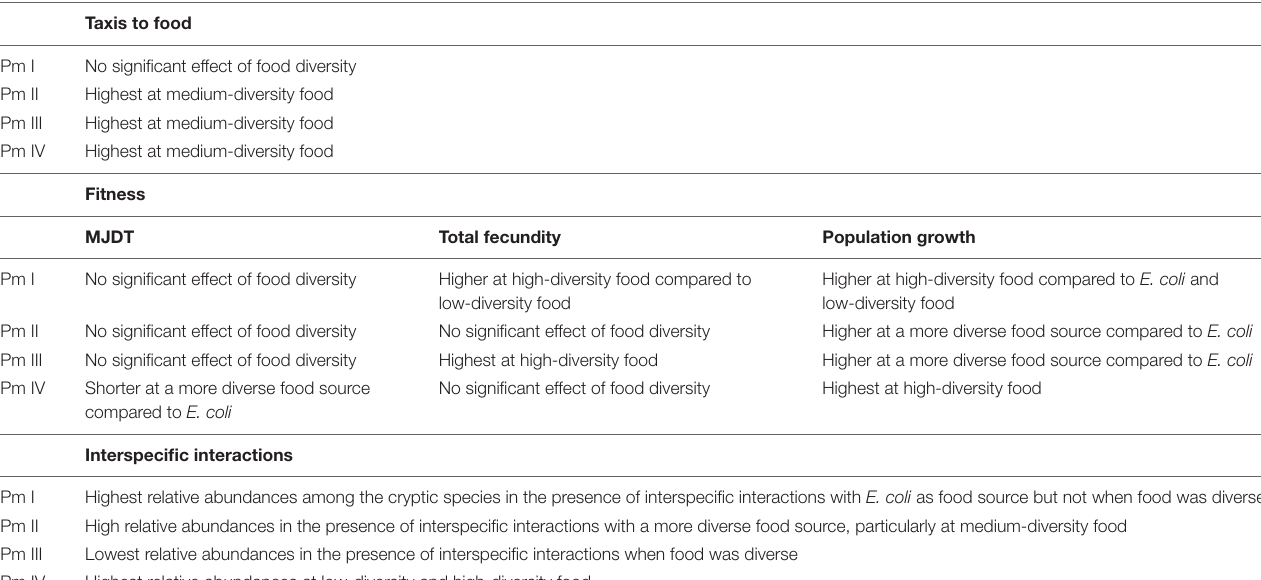
FIGURE 8 | Total absolute abundances of adult nematodes in (A) fictitious (summed based on the results of the monospecific cultures) and (B) real multispecies cultures at each time moment (7, 14, and 21 days) in different food treatments ( E. coli , low diversity, medium diversity, and high diversity) ( n = 4 ). TABLE 4 | Summary of the results for taxis-to-food, individual and population fitness, and interspecific interactions for each cryptic species of L. marina